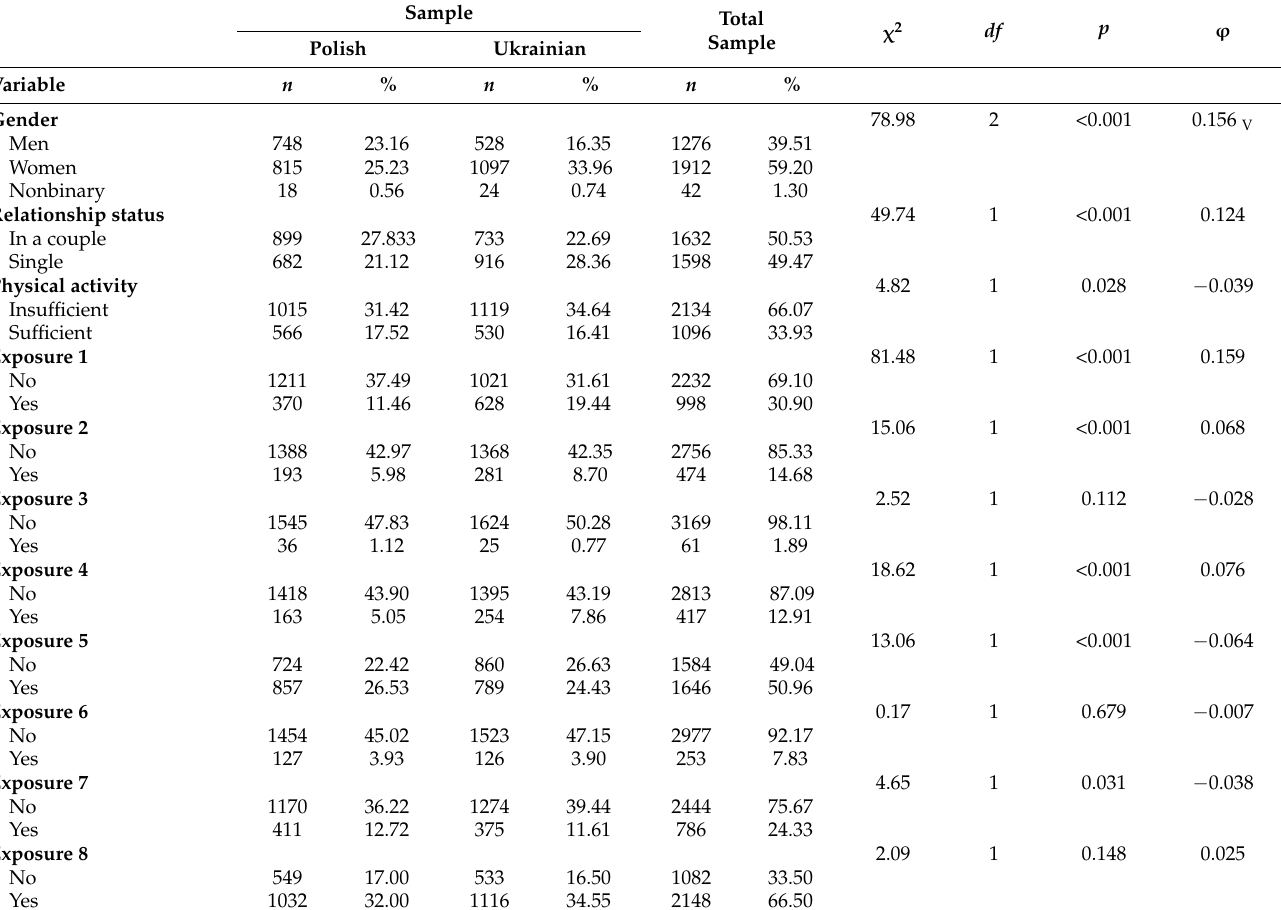
Table 1. A comparison of Polish and Ukrainian university students in gender, relationship status, physical activity, and exposure to the COVID-19 pandemic. Sample Total